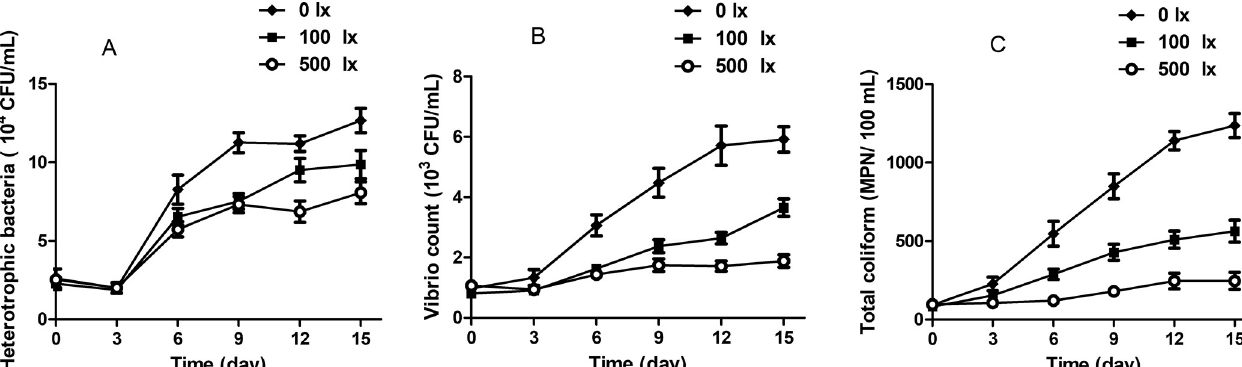
Fig 1. Bacterial growth in aquaculture water under 0 lx, 100 lx and 500 lx illumination: A) heterotrophic bacteria, B) Vibrio and C) total